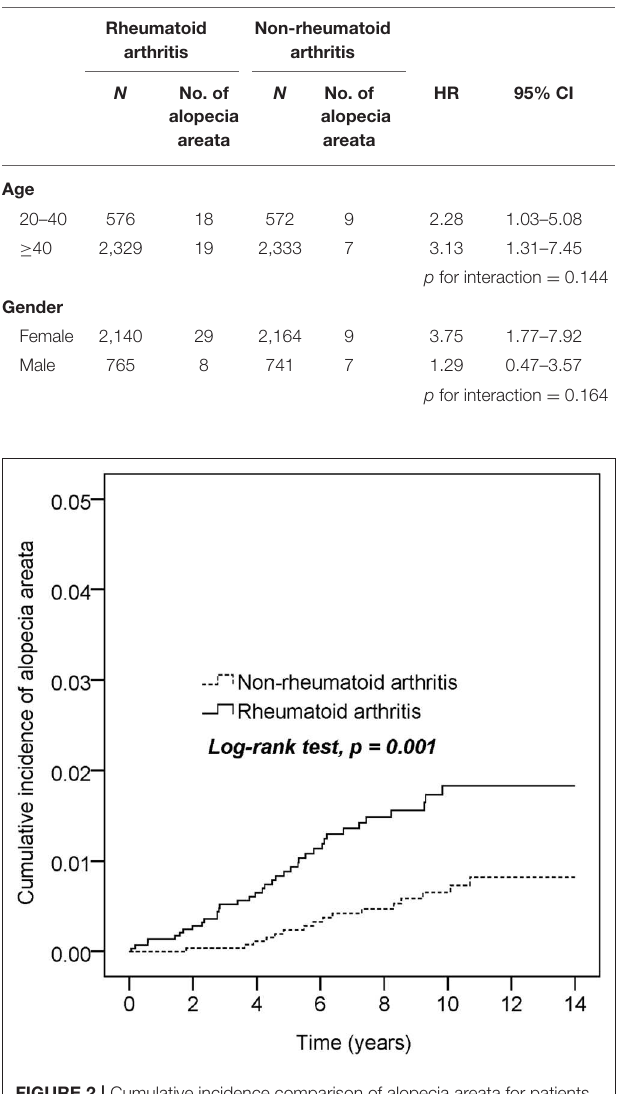
FIGURE 2 | Cumulative incidence comparison of alopecia areata for patients with or without rheumatoid arthritis.